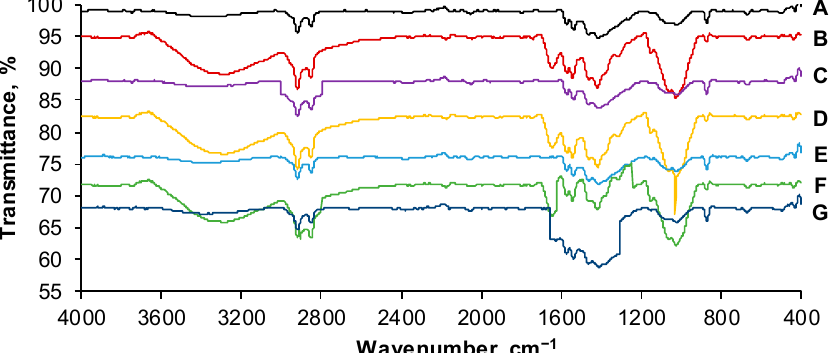
Figure 8. FTIR spectra for CSCH adsorbent before RB adsorption ( A ), after 1st, 2nd and 3rd cycle of RB adsorption ( B , D , F ) and after 1st, 2nd and 3rd cycle of RB desorption ( C , E , G ) (Device: IR- Spirit FT-IR spectrometer (Shimadzu, Bucharest, Romania); Accessory: QATR; Wavenumber range: 4000 cm − 1 –400 cm − 1 ; Scans: 45 scans/min.; Resolution: 4 cm − 1 ; Background spectrum reference: air; Cleaning solution: